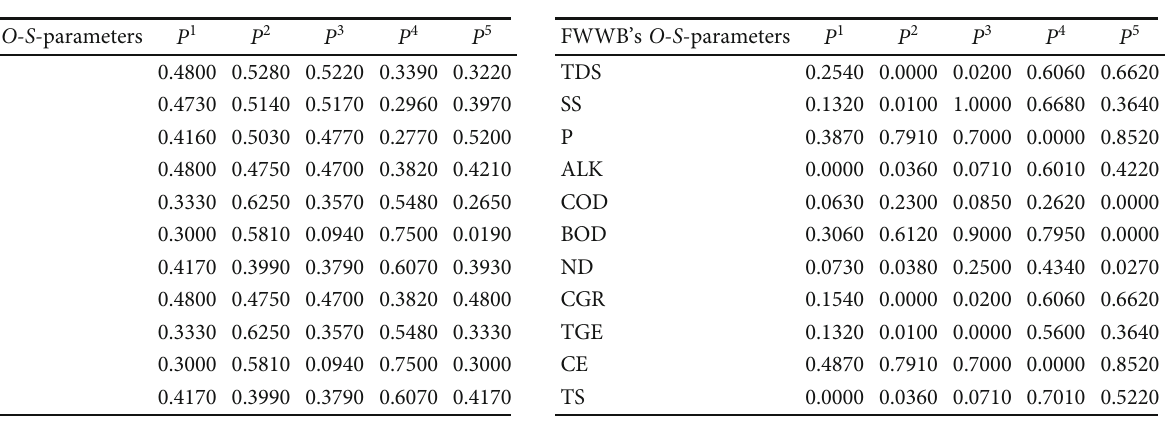
linking FWWB ’ s i